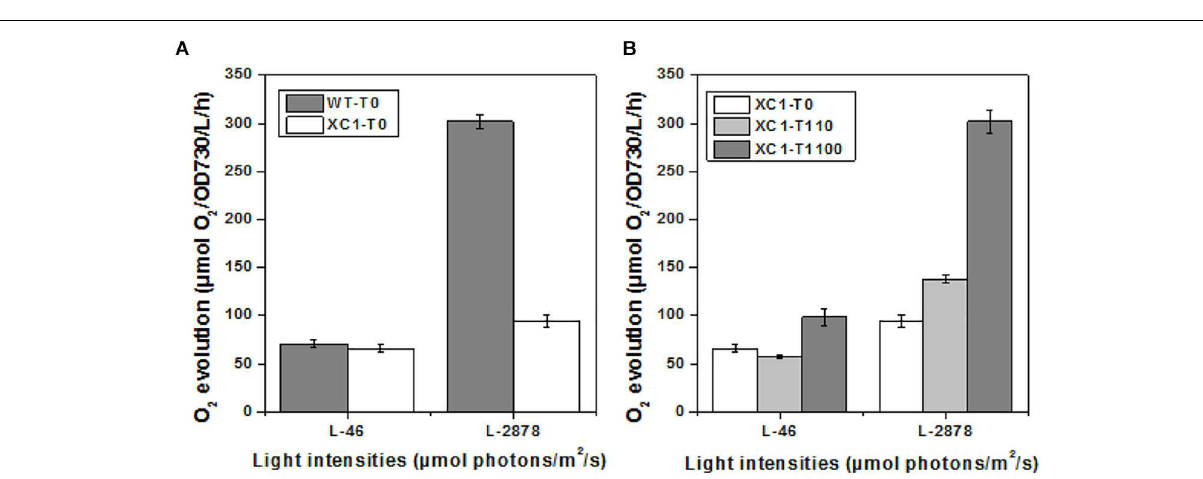
FIGURE 4 | Oxygen evolution of PCC7942-WT and PCC7942-XC1 cells under different illumination. L-46 represented light intensities of 46 µ mol/m 2 /s; L-2878 represented light intensities of 2878 µ mol/m 2 /s. The data shown are averages of at least three independent measurements, and standard deviation bars are also shown. (A) PCC7942-WT and PCC7942-XC1 under 0 µ M theophylline; (B) PCC7942-XC1 under induction of 0 µ M, 110 µ M, 1100 µ M theophylline,